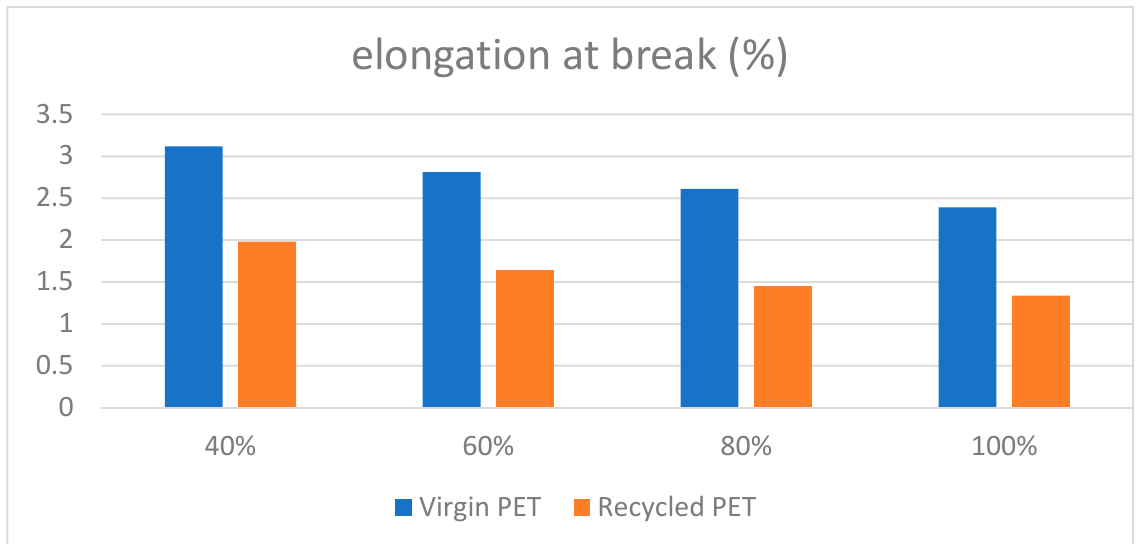
Figure 7. Elongation at a break of a recycled and virgin 3D printed PET. Distinct extensometers were not used and the elongation and load were not recorded.